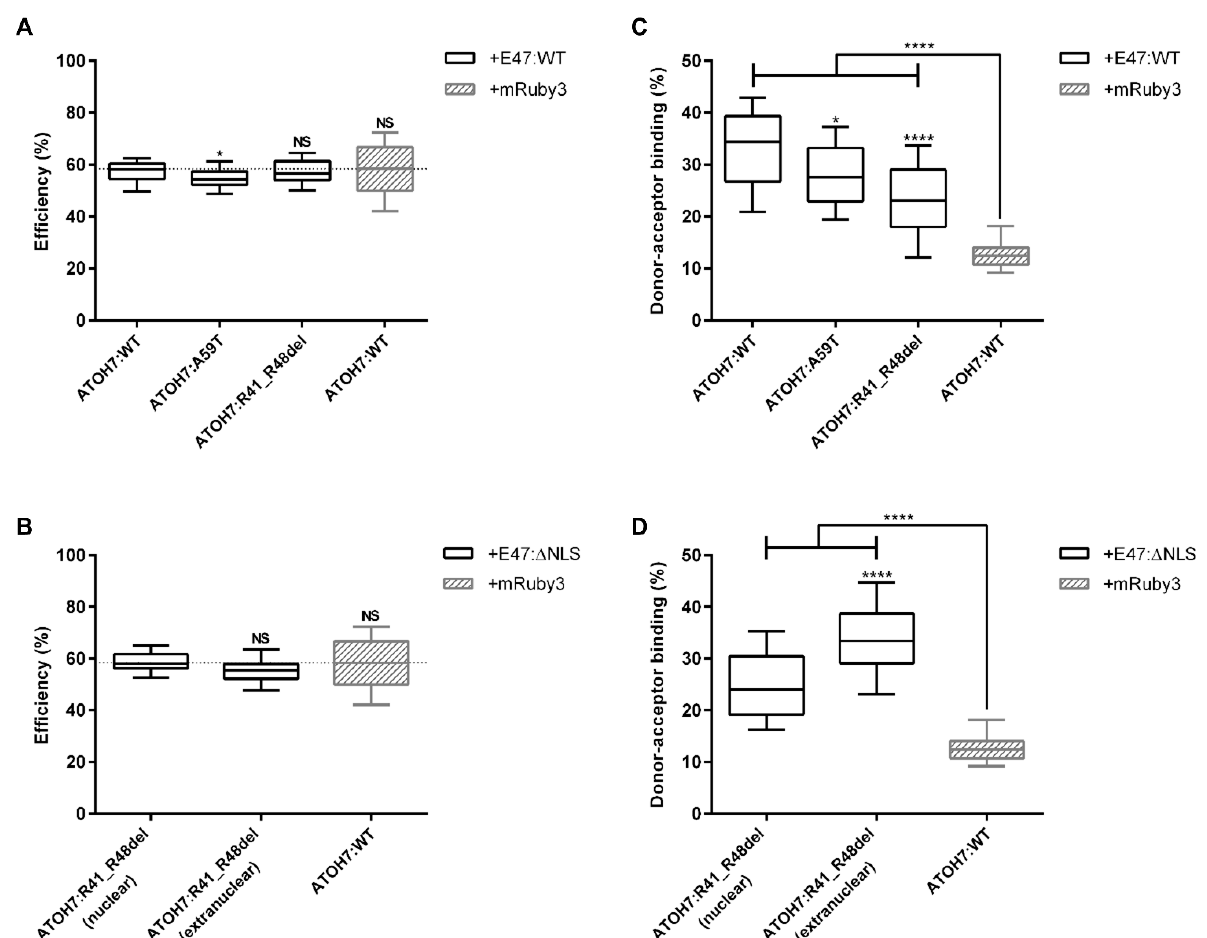
Figure 4. Reduced nuclear dimerization of mutant ATOH7:R41_R48del protein and possible